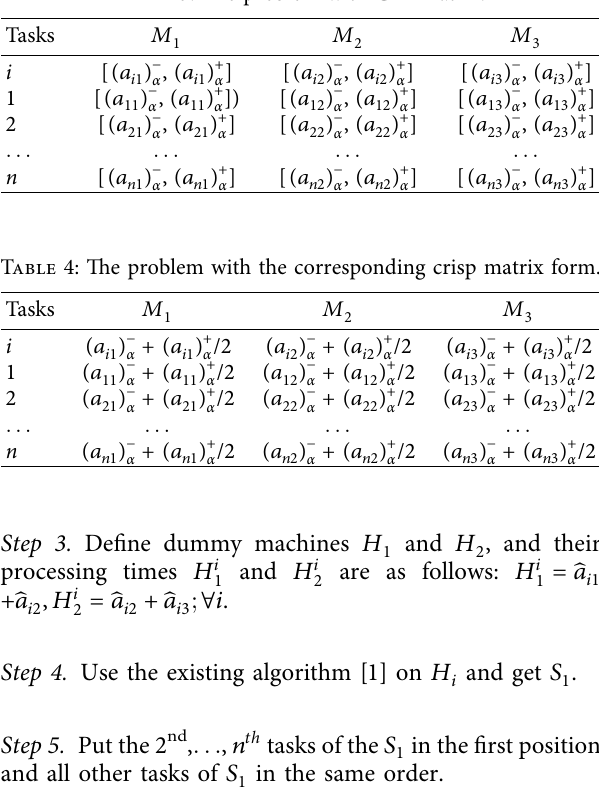
Table 3: The problem with CIA matrix.